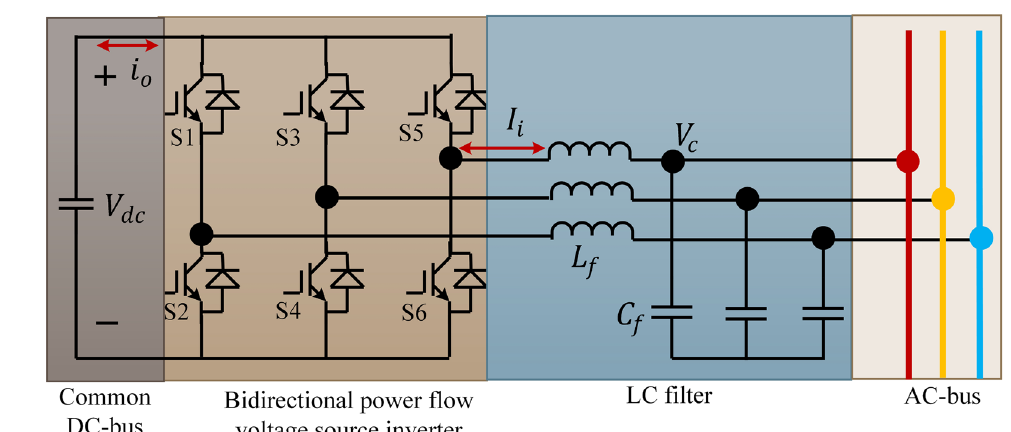
Fig. 2 An equivalent circuit diagram of the